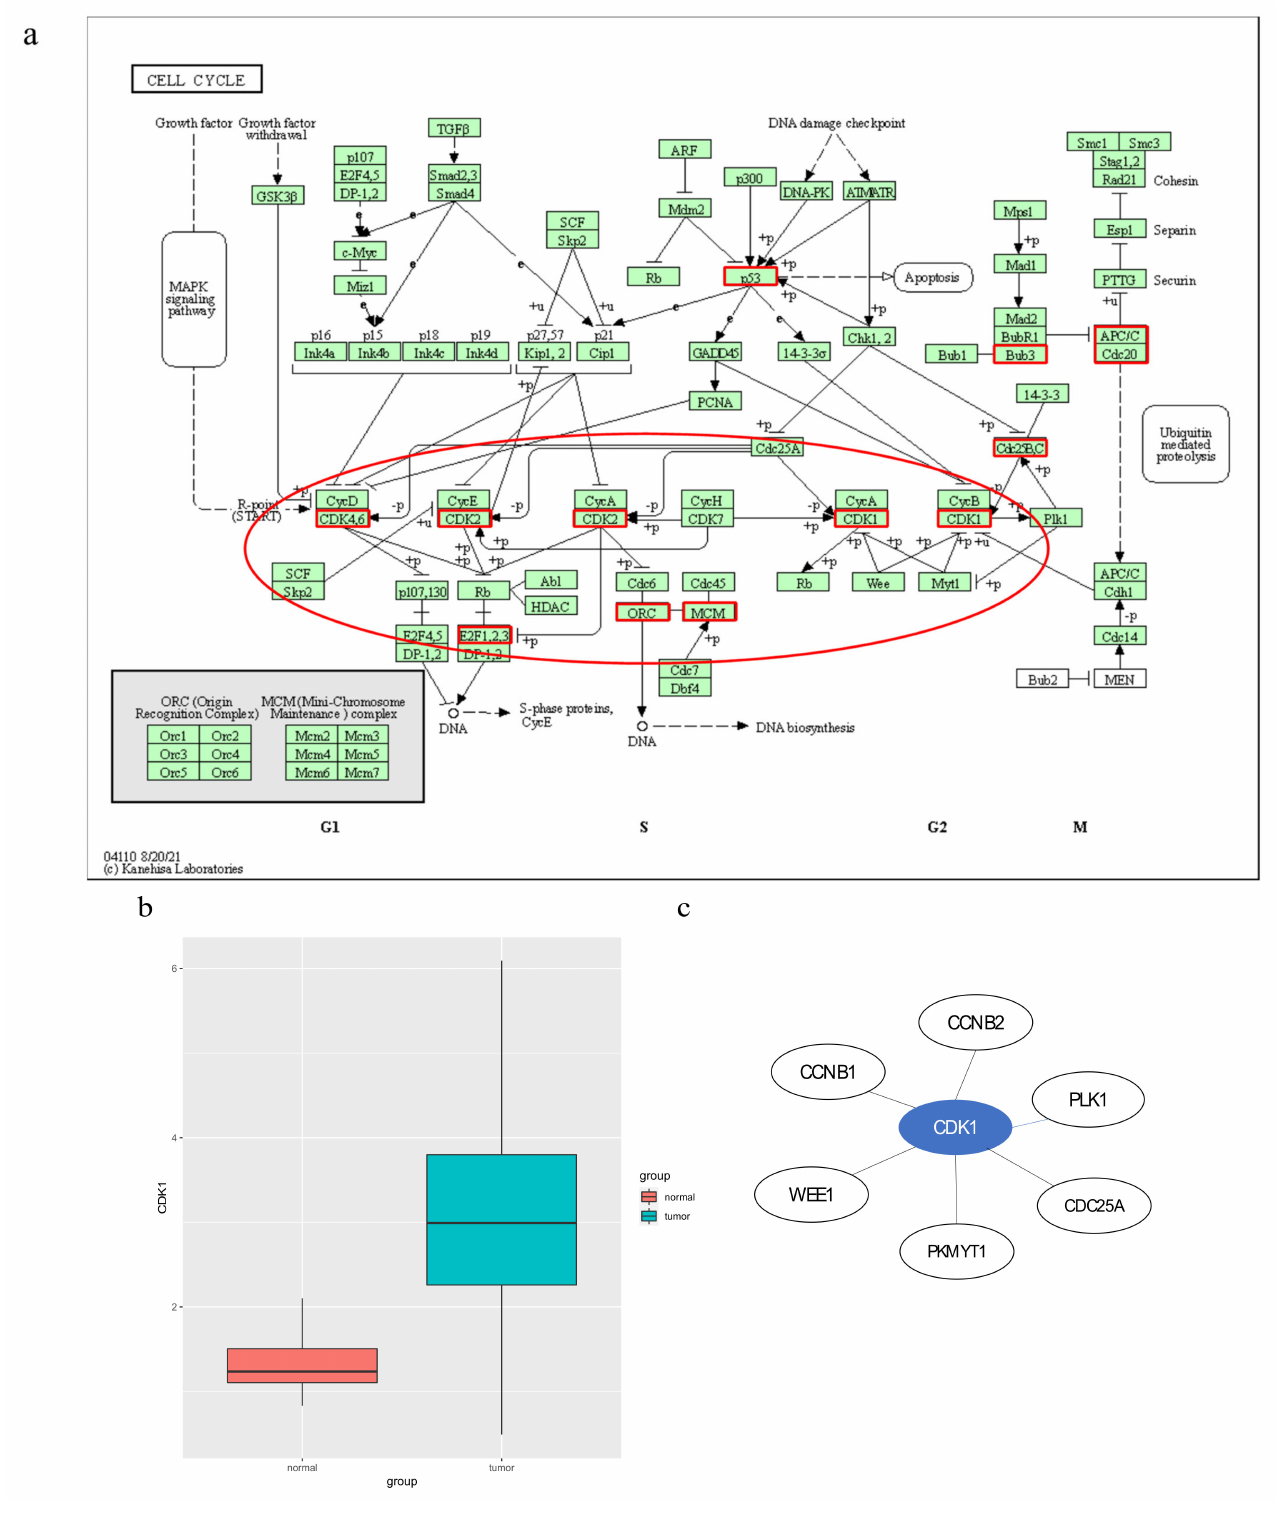
Figure 7. ( a ) The cell cycle pathway in KEGG. Red borders represent genes mapped to the subpathway. Key subpathway region is shown in red ellipse; ( b ) the CDK1 expression value between normal and tumor samples in LUAD. ( c ) Common subnetworks of CDK1 from some samples for